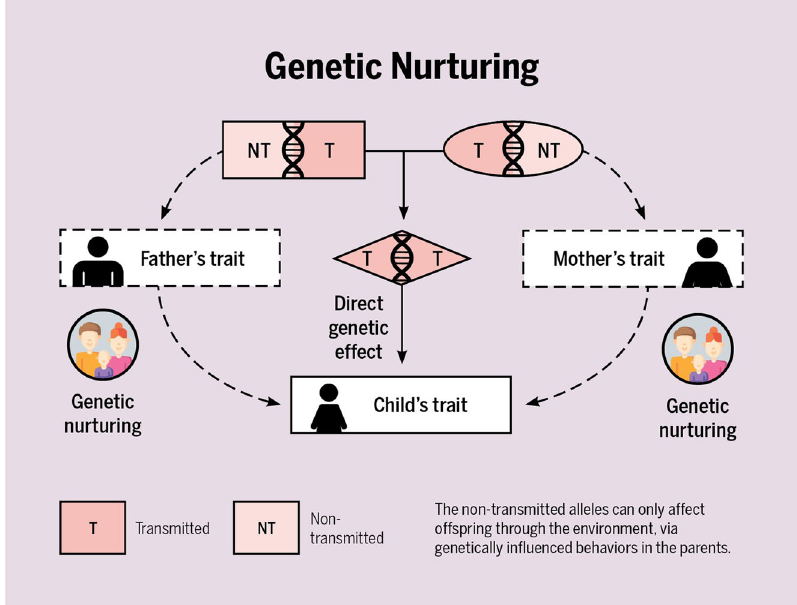
Fig. 7 Simpli fi ed representation of the genetic nurturing design. In this design, one needs genotypes of parents and offspring, and a measured trait in the offspring generation only. The trait in the parents, for example educational attainment, is unobserved and indexed by a polygenic score of, in this example, educational attainment. The child receives half of the genotypes of father (top left) and mother (top right) and these transmitted alleles in fl uence the child trait directly. The parental alleles that the child does not receive can still in fl uence the child trait indirectly, via genetically in fl uenced behaviors in the parents (denoted by the dotted genetic-nurturing paths). Genetic nurturing is present if the polygenic score of the untransmitted alleles explains a signi fi cant proportion of the variance in the child trait. The proportion of variance explained by the polygenic score of the transmitted alleles include both genetic nurturing and direct effects. Note that ‘ child ’ can refer to child or adult offspring. T = transmitted, NT = non-transmitted. Figure adapted from ref. 39 . Figure by ref. 66 available at https://bit.ly/ 2PjpkRu under a CC BY 4.0